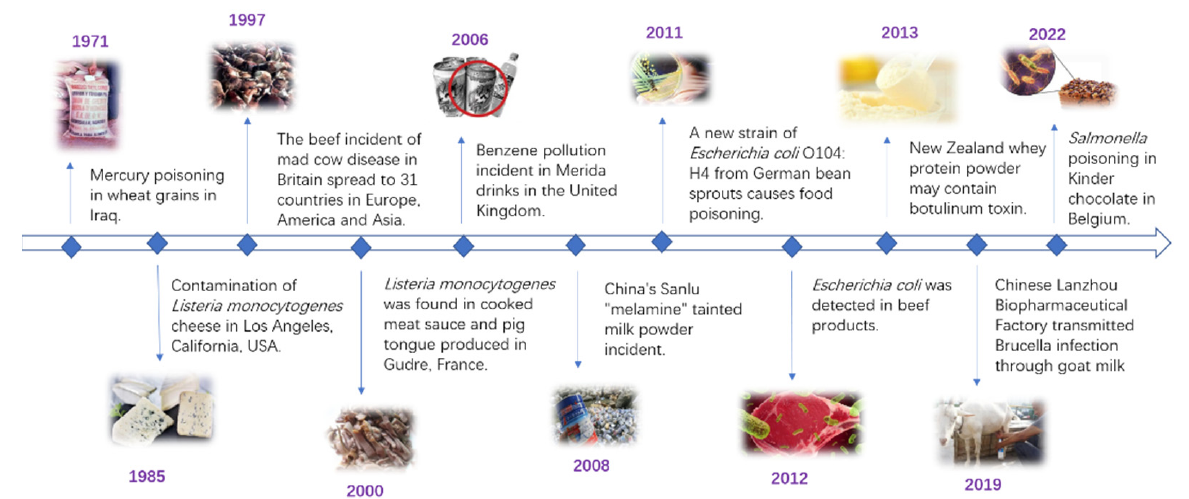
Figure 1. A brief timeline of the typical food safety issues.